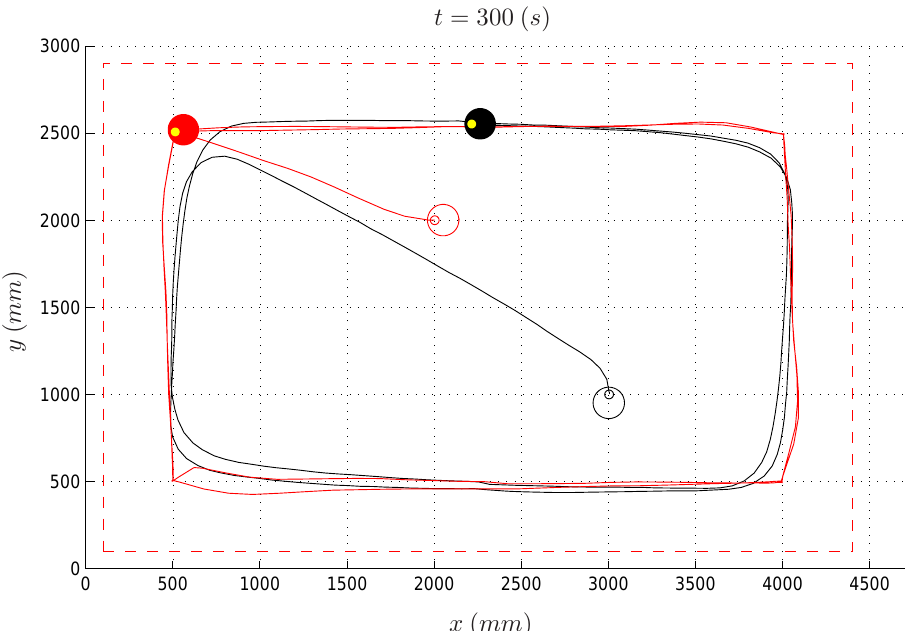
Figure 11. Pursuer-evader games, Algorithm 1: pursuer (black) and evader (red) with a PE speed ratio equal to